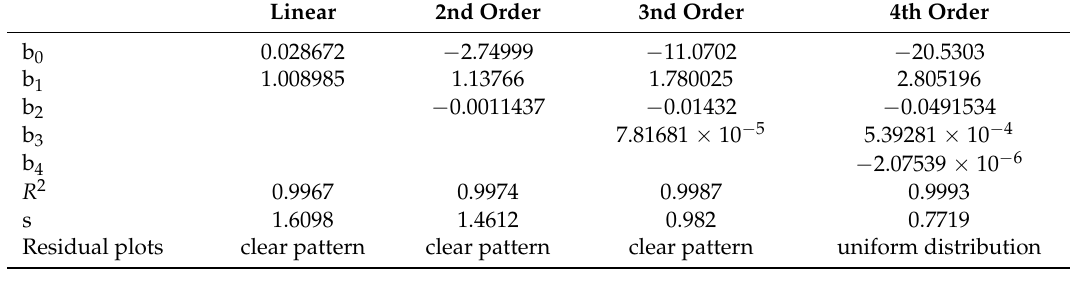
Table 4. Estimated parameters and evaluation criteria for the linear and several polynomial equations for THT-B121 resistive sensor using 11 salt solutions.